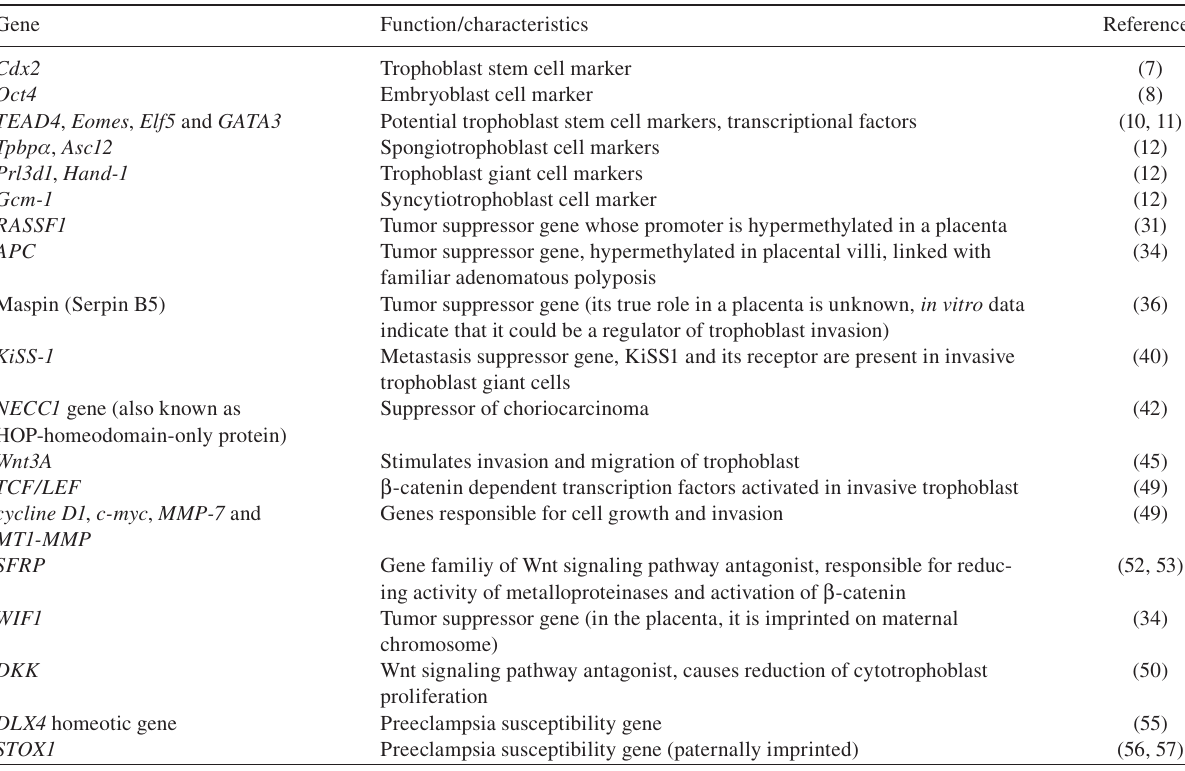
Table 1 Genes expressed in trophoblast and cancer